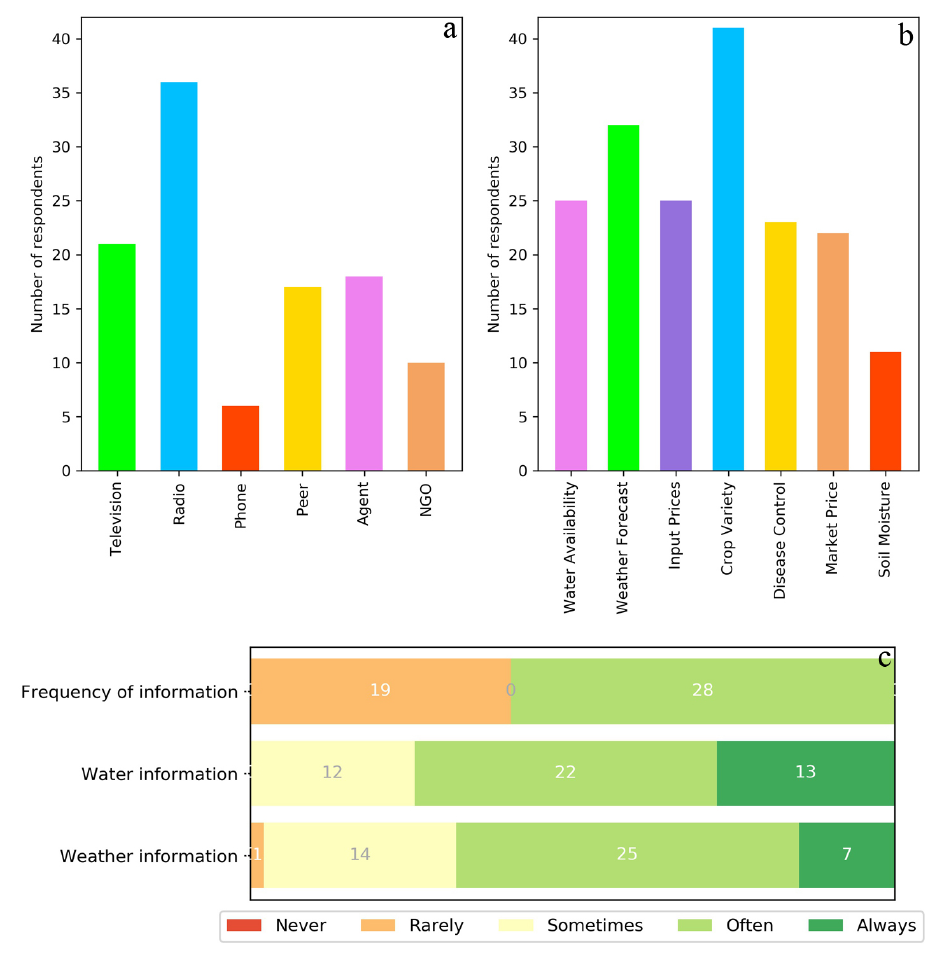
Figure 2. Agricultural-related information received by the smallholder farmers and their dependency on weather and water information for farming decision-making. ( a ) Source of information, ( b ) type of information, ( c ) frequency of information received by farmers, dependency on water (mainly runoff and residual water content) and weather